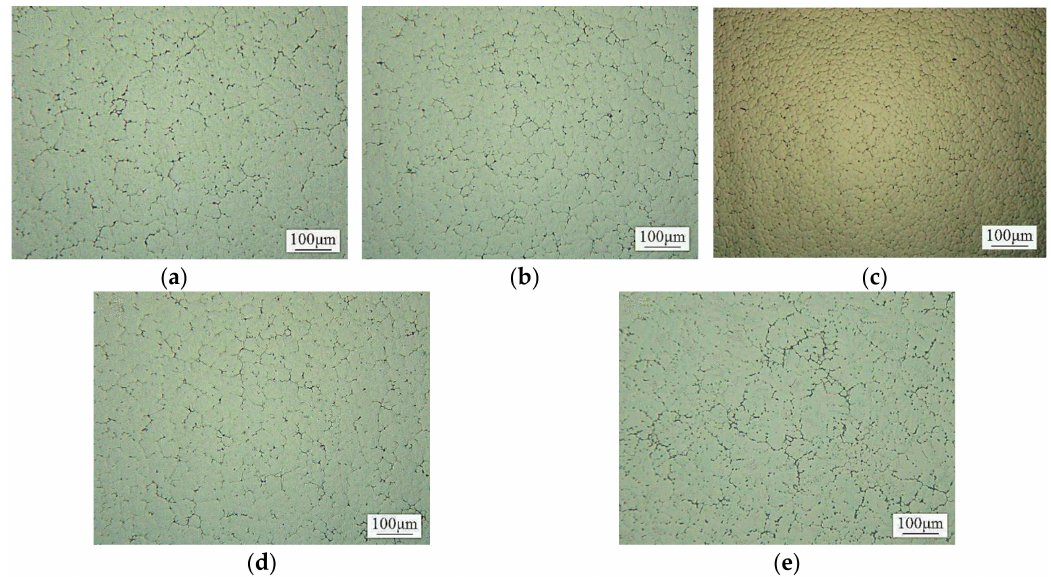
Figure 1. Optical microstructures of as-cast Al-5Mg- x Zr alloys: ( a ) x = 0; ( b ) x = 0.06; ( c ) x = 0.12; ( d ) x = 0.24; ( e ) x = 0.5.